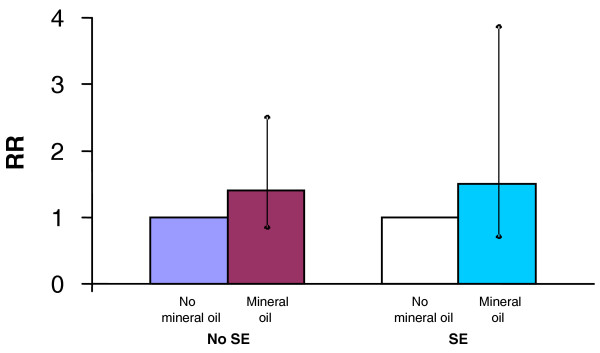
Relative risk of anti-CP-positive RA with mineral exposure and different expression of SE genes. The relative risk (RR) of developing rheumatoid arthritis (RA) positive for antibodies to citrulline-containing peptides (anti-CP) with mineral exposure and shared epitope (SE) genes compared with unexposed subjects with SE genes is 1.4, with 95% confidence interval = 0.8–2.4. The corresponding risk among subjects with no SE gene is 1.5, with 95% confidence interval = 0.6–3.9.